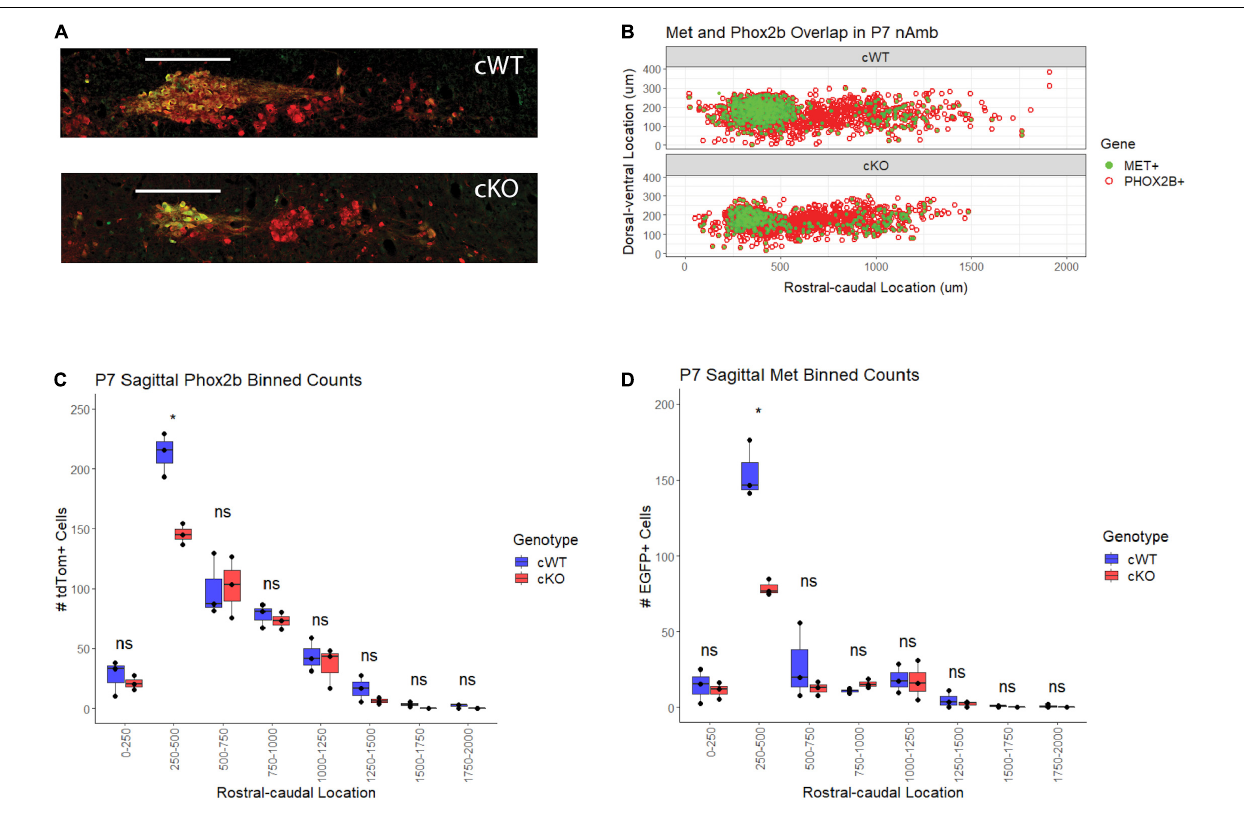
( Figure 5H ), consistent with the absence of a subpopulation neurons in the nAmb following deletion of Met .